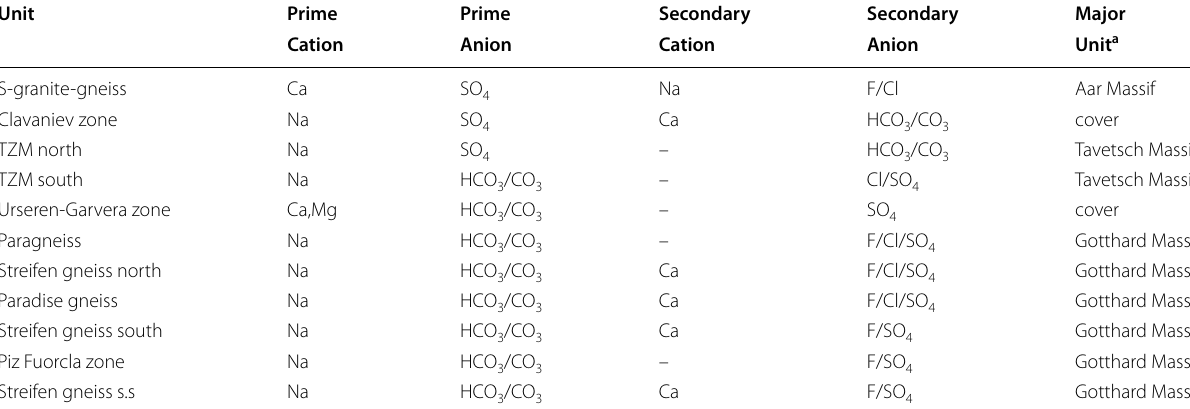
a Major unita: Aar Massif, Gotthard Massif meta-sediments